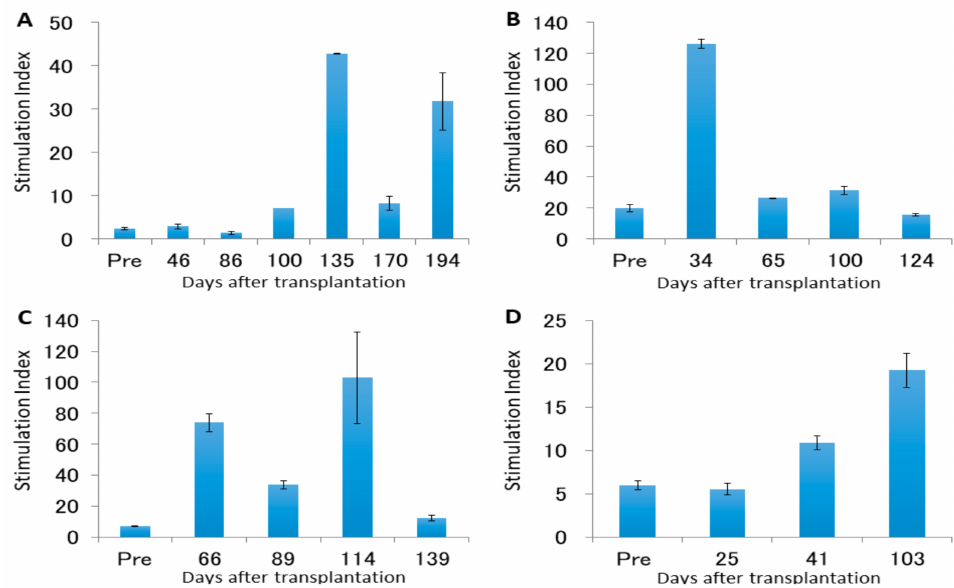
Figure 8. Mixed lymphocyte reaction (MLR) stimulation indexes pre- and post-transplantation. ( A ) Case 1. ( B ) Case 2. ( C ) Case 3. ( D ) Case